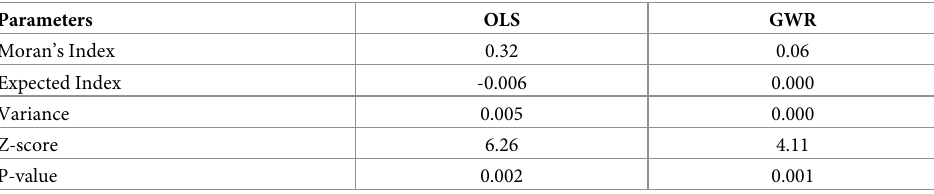
Table 7. Comparison between Moran’s I summaries for OLS and GWR